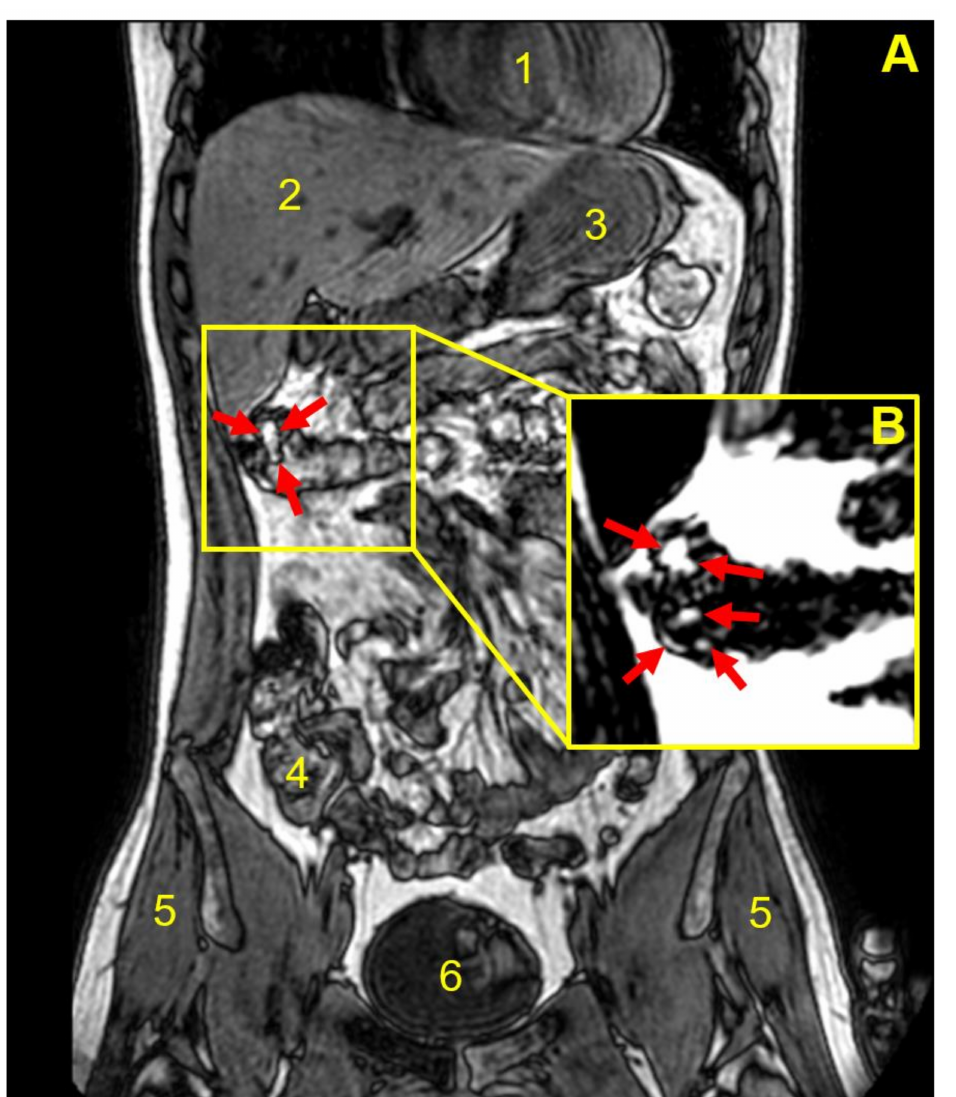
Figure 3. Coronal, fat and water out of phase MRI image of the abdomen of participant number 3, acquired 180 min after consumption of the coated capsule with 240 mL of water. Anatomical landmarks are indicated by numbered labels: heart ( 1 ), liver ( 2 ), stomach fundus ( 3 ), transverse colon ( 4 ), gluteus medius muscle ( 5 ) and bladder ( 6 ). ( A ) The filled capsule appears bright and is located in the ascending colon/hepatic flexure of the large intestine. The capsule here appeared deformed and unevenly filled. The inset ( B ) is from the corresponding fat only MRI image, capturing oil leaks out of the capsule into the colon indicated by the red